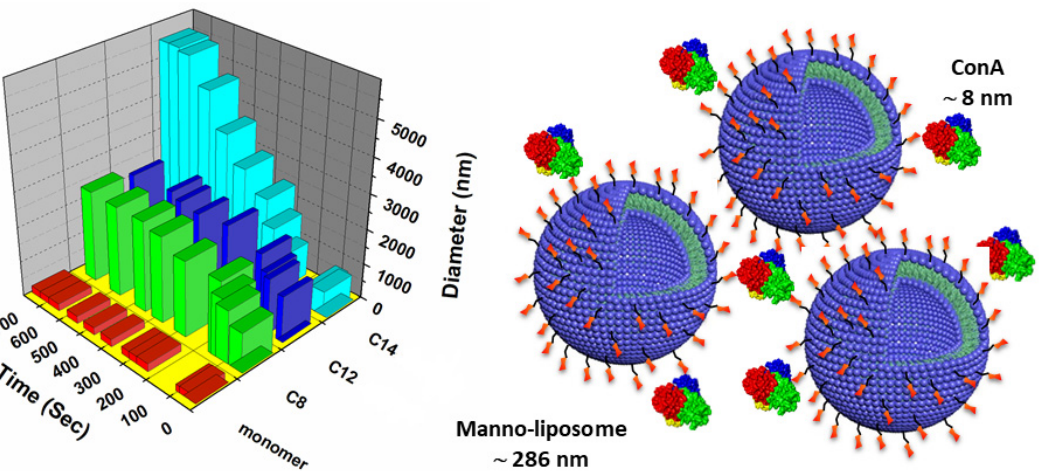
Figure 3. Time scale agglutination of mannosylated liposomes 21 (C 8 ), 23 (C 12 ), and 24 (C 14 ) in the presence of Con A (4 binding sites/mol) at 0.5 mg/mL (100 μ L) in PBS.